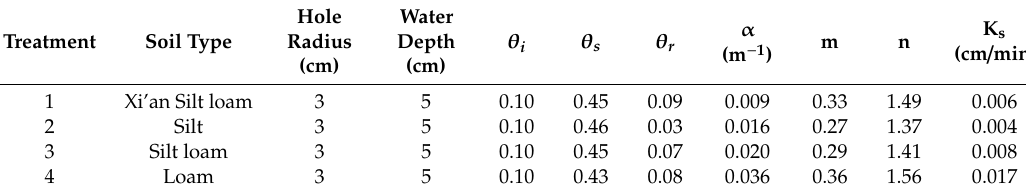
Table 1. Scheme and parameters for numerical simulation experiment.